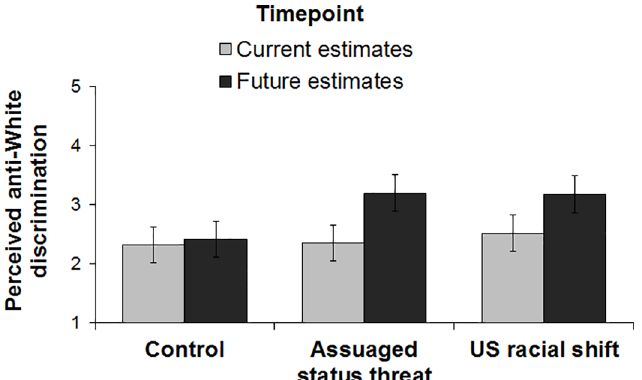
Fig 1. Perceived anti-White discrimination by experimental condition and timepoint (Study 1). Error bars represent within-subjects 95% confidenceintervals[27].